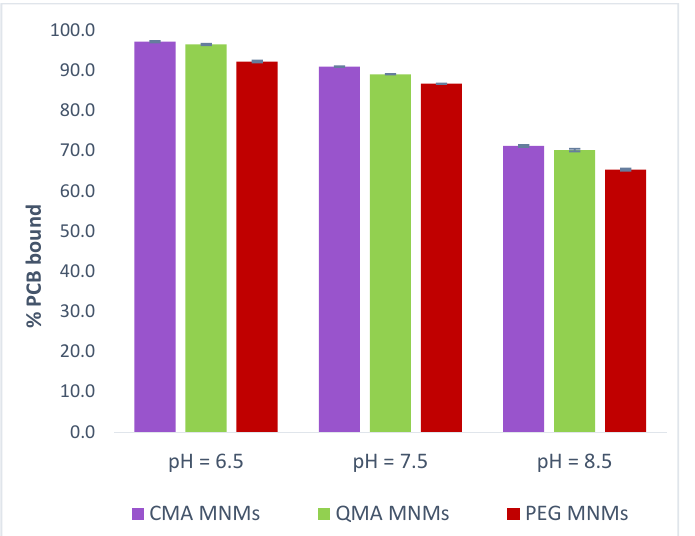
Figure 4. E ff ect of pH on the sorption e ffi ciency of PCB 126 on CMA MNMs, QMA MNMs, and PEG Figure 4. Effect of pH on the sorption efficiency of PCB 126 on CMA MNMs, QMA MNMs, and MNMs. PEG